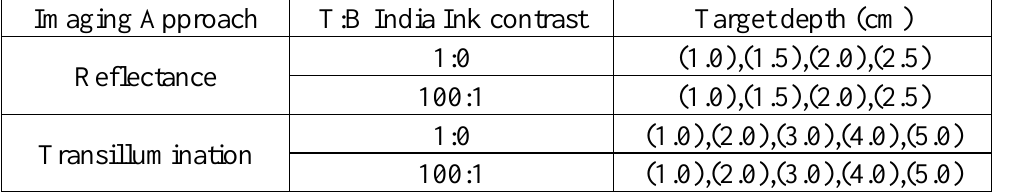
Table 1. Experimental cases for simultaneous bilateral reflectance and transillumination imaging studies. In all the studies 3% Liposyn solution was used in the background phantoms and a 0.45 cc target was with 0.08% India Ink + 3% Liposyn solution. In 100:1 contrast ratios, a 0.0008% India Ink is added to the